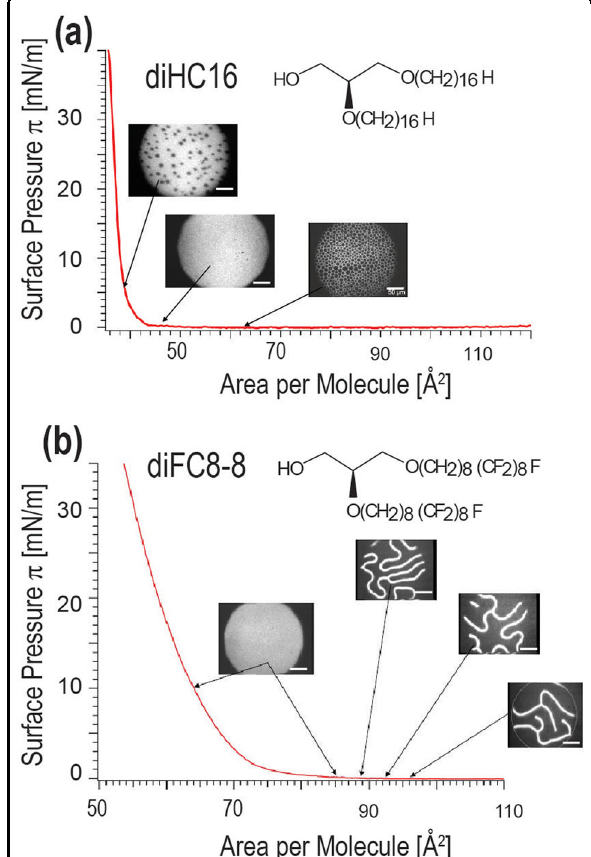
Fig. 1 Self-assembly of lipids with fully hydrogenated and partly fl uorinated chains. a Fully hydrogenated diHC16 forms circular, bubble-like domains. b In contrast, partly fl uorinated diFC8-8 forms stripe-like domains soon after the surface pressure increases because of corresponding to the coexistence of gas and liquid-expanded phases. The liquid-expanded phase was labeled with fl uorescent Texas Red dihexadecyl phosphatidylethanol amine. Partially adapted from ref. 30